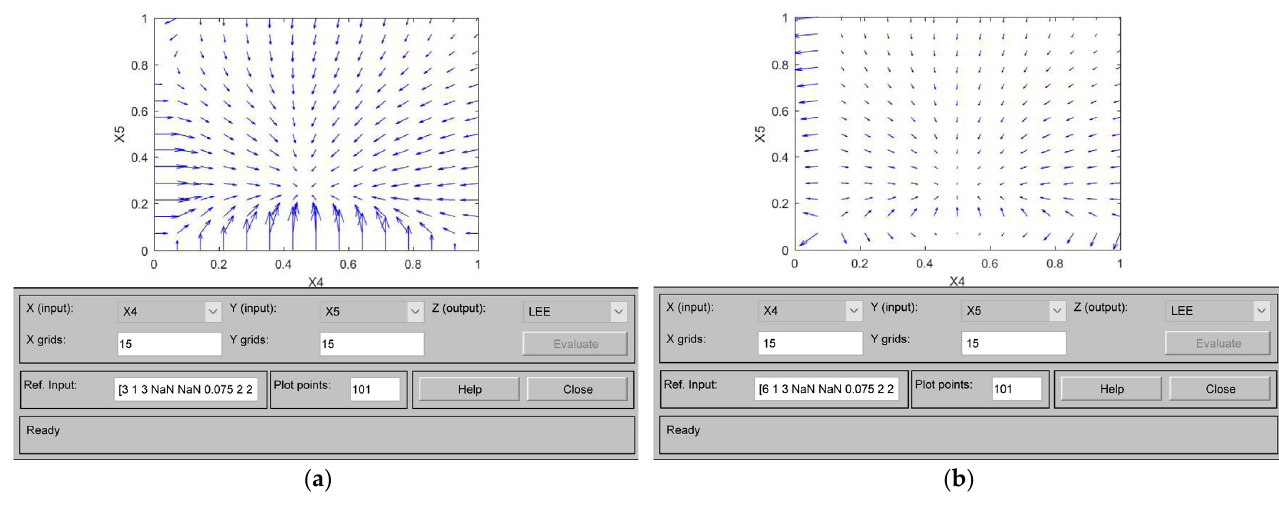
Figure 5. Optimal values of the LEE ( x 4 , x 5 ) : ( a ) bus, ( b ) truck.